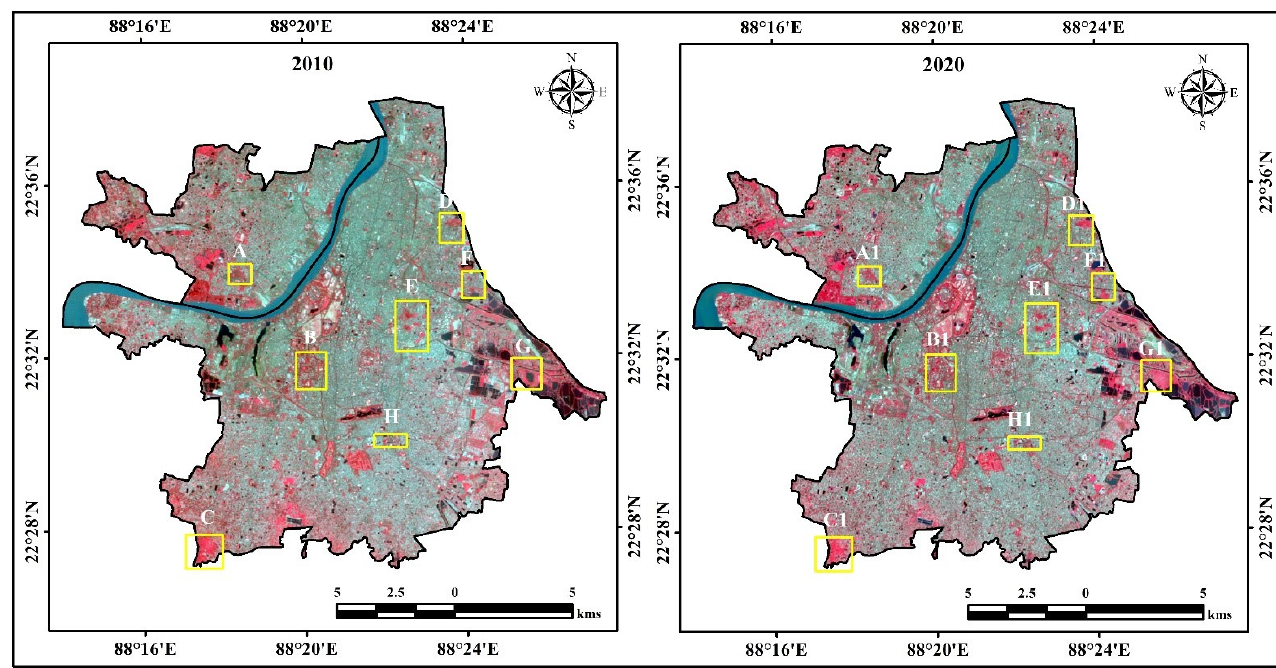
Figure 1. Vegetation degradation area identification on satellite images in 2010 and 2020 for West Bengal (Kolkata and Howrah).